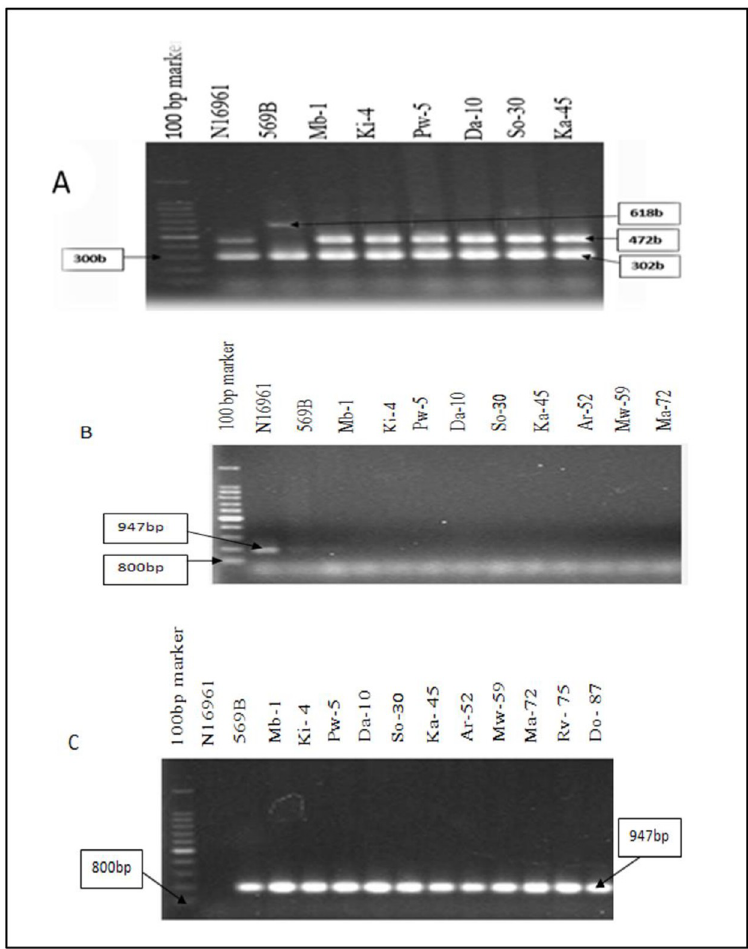
Fig 4. MAMA PCR gel electrophoresis. Examples of electrophoresis results of MAMA PCR products of V . cholerae O1 strains A: Detection of ctxA (302bp) and tcpA (472bp) genes. B: Detection of biotype-specific cholera toxin B ( ctxB ) El Tor gene. C: Detection of biotype-specific cholera toxin B (ctxB) Classical gene. Positive control (569B) and negative control (N16961) for ctxB (El Tor) gene were used. V . cholerae DNA; Mb-1(Mbeya- 2017), Ki-4 (Kigoma 2017), Pw-5 (Pwani 2017), Da-10 (Dar-es-Salaam- 2017), So-30 (Songwe 2017), Ka-45 (Katavi 2017), Ar-52 (Arusha 2016), Mw-59 (Mwanza 2016), Ma-72 (Mara 2016), Rv-75 (Ruvuma 2017), and Do-87 (Dodoma 2016). The numbers represent the DNA